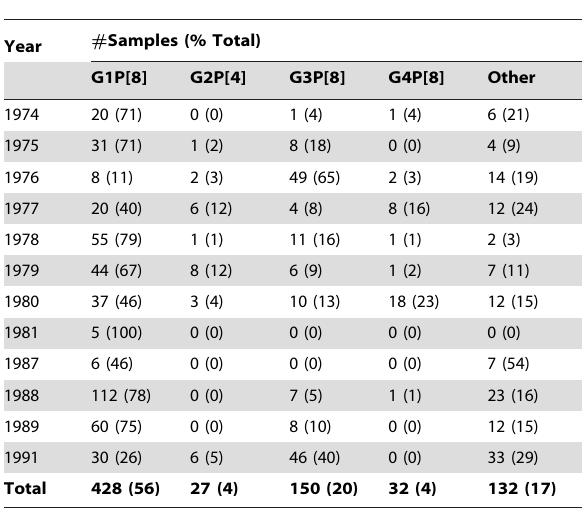
Table 1. Distribution of RV G/P-types from Sick Children in Washington, DC